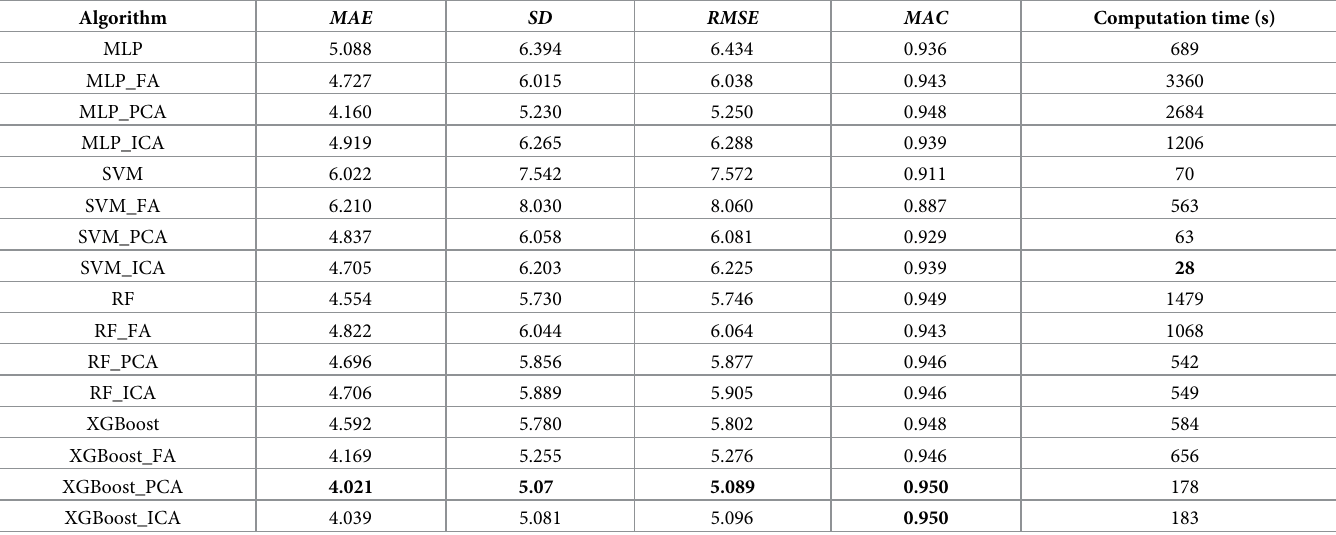
Table 9. Experimental results based on the NHANES dataset (best results are highlighted in bold).